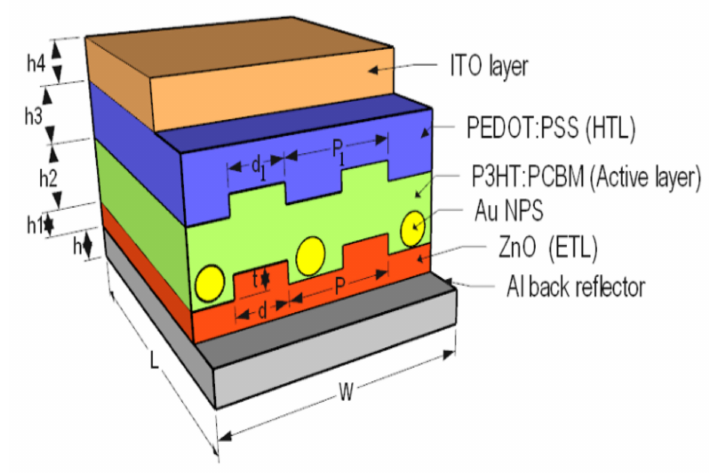
Figure 1. Schematic diagram of the proposed structure.